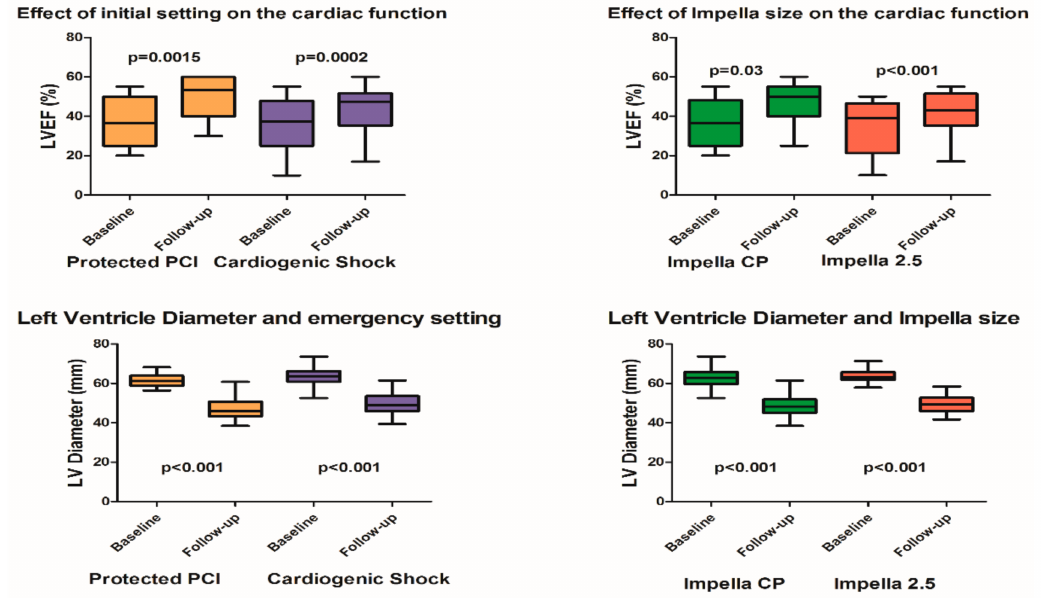
Figure 1. Impact of Impella support on the left ventricle function and diameter according to the initial setting and Impella size. Device related ischemic vascular complications occurred in 10 (11.9%) patients. These complications included six patients needing device extraction [4 patients with Impella 2.5 (6.7%) and two patients with Impella CP (8.3%), all patients with cardiogenic shock (9.7%)] and four patients requiring intervention ((percutaneous angioplasty ( n = 2) or surgical repair ( n = 2), all patients in the Impella 2.5 group (6.7%) and with cardiogenic shock (6.5%)). Access-site bleeding requiring transfusion occurred in 9 (10.7%) patients. None of our patients experienced an in-hospital or during follow-up stroke or myocardial reinfarction. None of